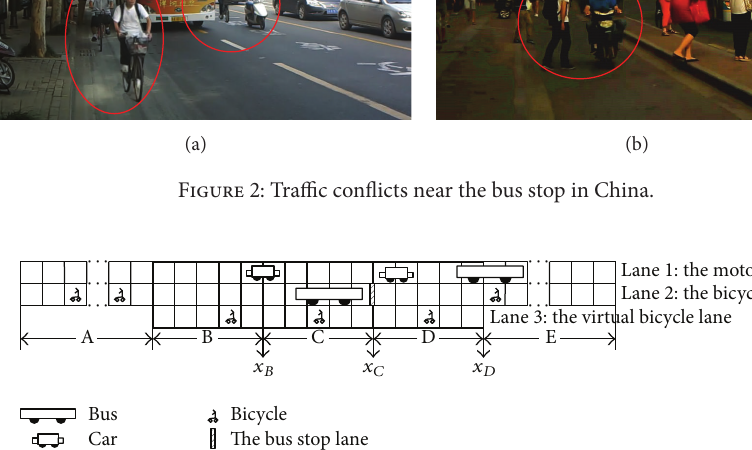
Figure 3: Sketch of the road in the mixed traffic